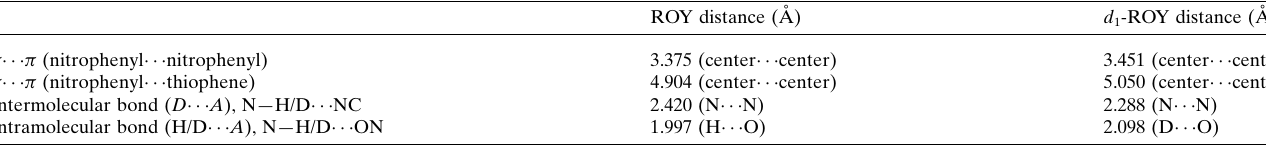
Table 1 Intermolecular and intramolecular bond lengths of the Y polymorph in ROY and d 1 -ROY.